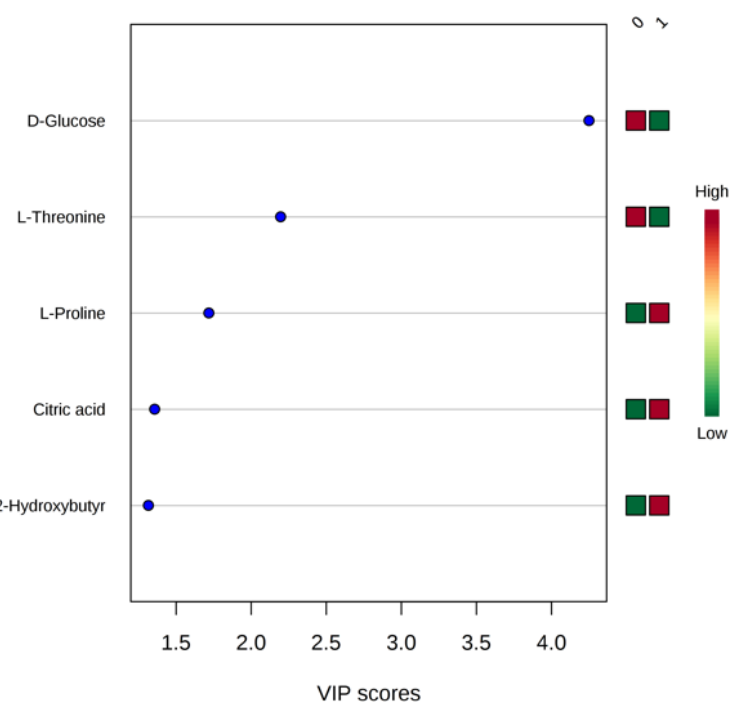
Figure 3. VIP score analysis: metabolites discriminating female fibromyalgia patients (1) from control (0) based on NMR metabolomic sera analysis. Table 2. Pathway analysis using MetaboAnalyst and Reactome.